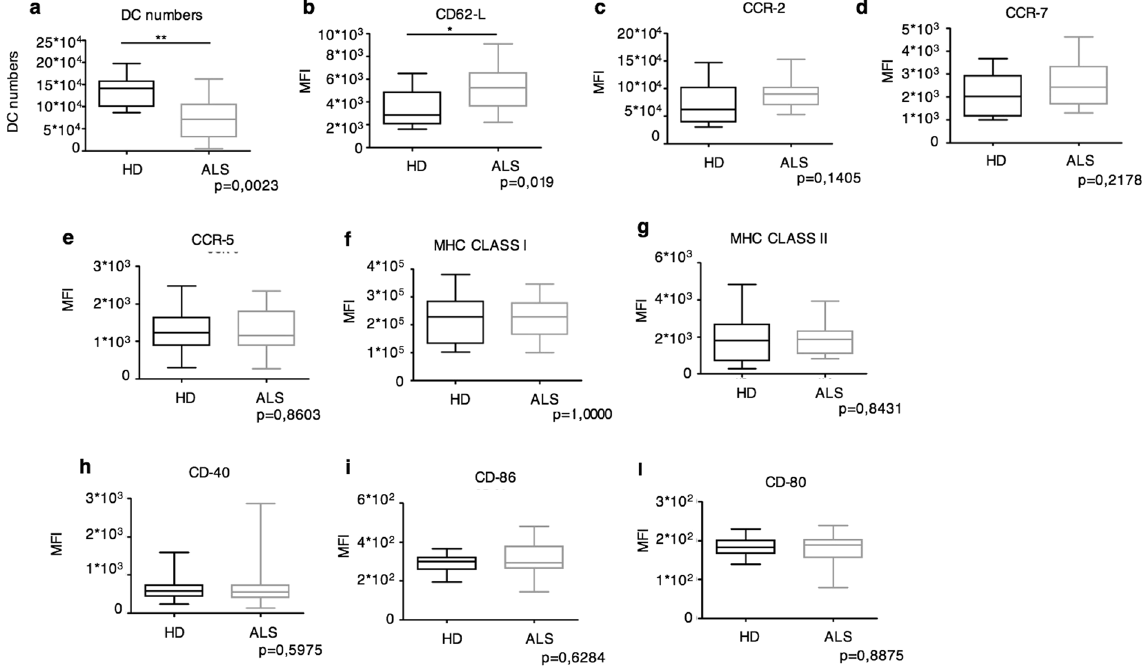
Figure 1. Phenotypic analysis of peripheral blood DCs in ALS patients compared to HD. ( a ) Box plots of absolute numbers of CD1c + CD19 − DCs in the peripheral blood of ALS patients (ALS, n = 20) and HD (n = 10). ( b – l ) Box plots of the Mean Fluoresce Intensity (MFI) of the indicated molecules in ALS patients compared to HD. * P < 0.05; ** P <